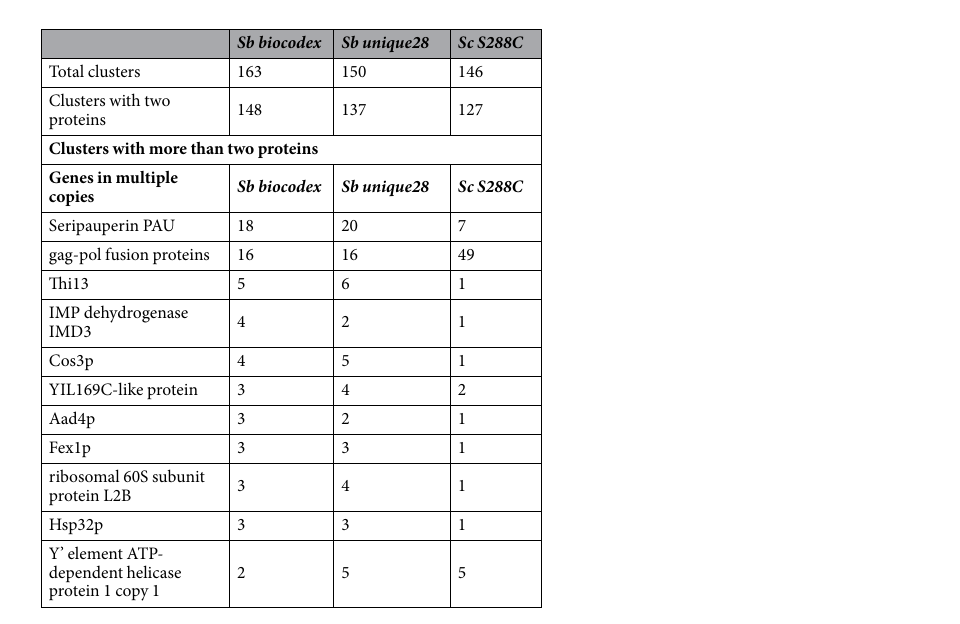
Table 3. Multicopy genes in Sb - biocodex, Sb - unique28 and Sc S288C